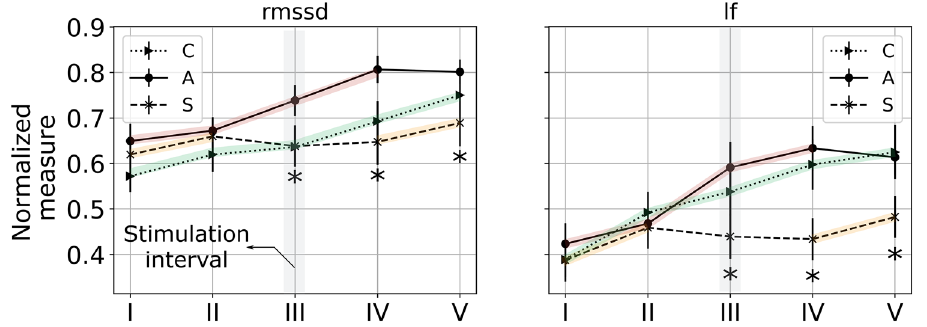
Figure 3. Mean and standard error of HRV features across the five phases: RMSSD (time-domain), LF-power (frequency-domain). The shaded segments represent consecutive time points where a statistically significant effect of time was found; the asterisk presents time points (phase) where a significant effect of condition was evidenced.